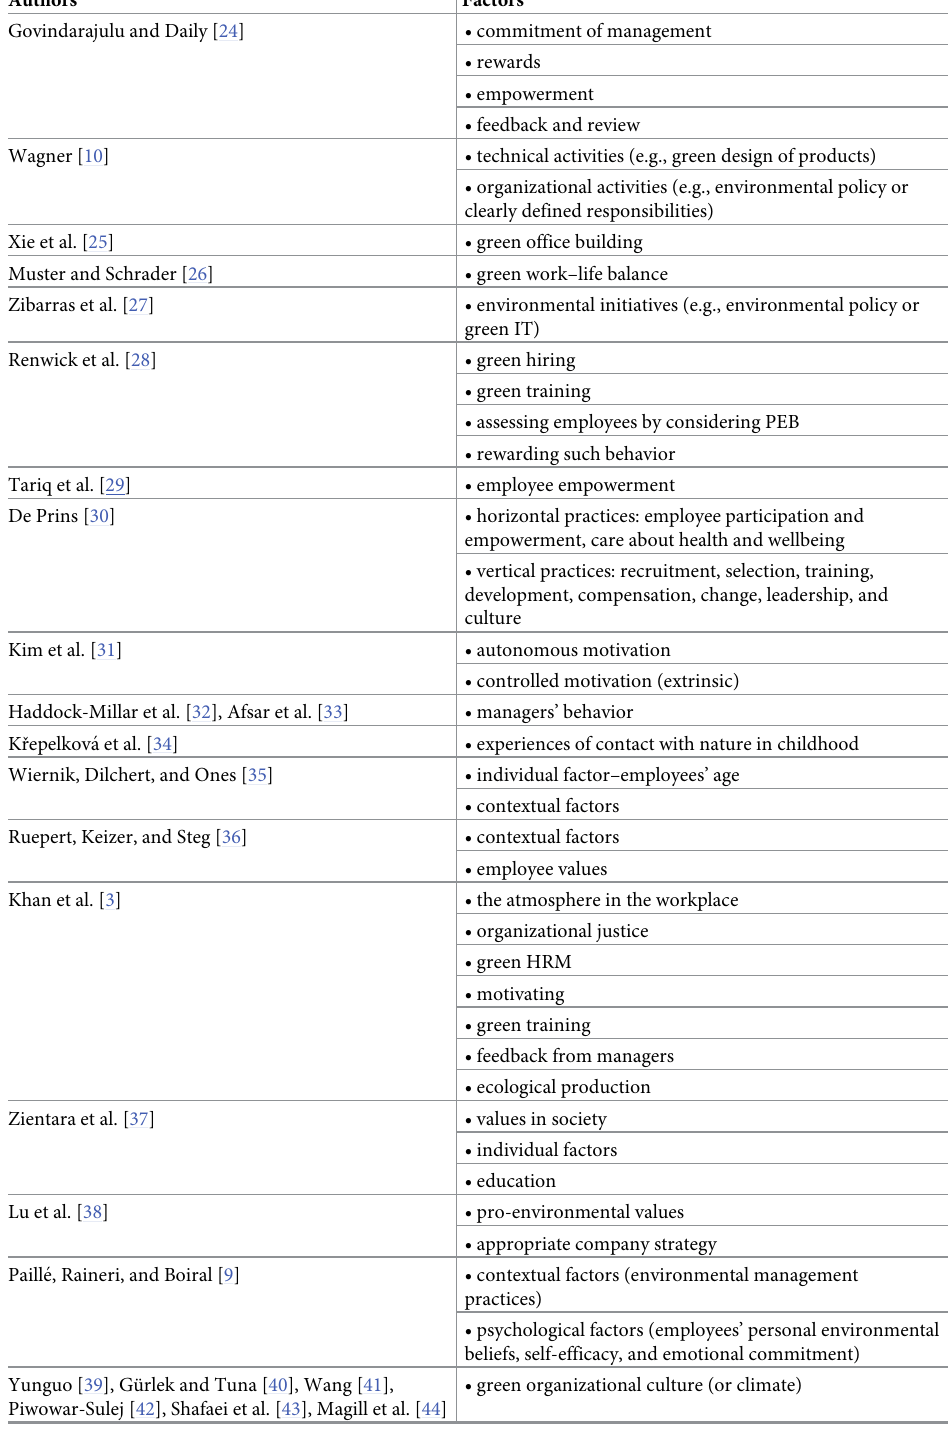
Table 1. Factors that influence employees’